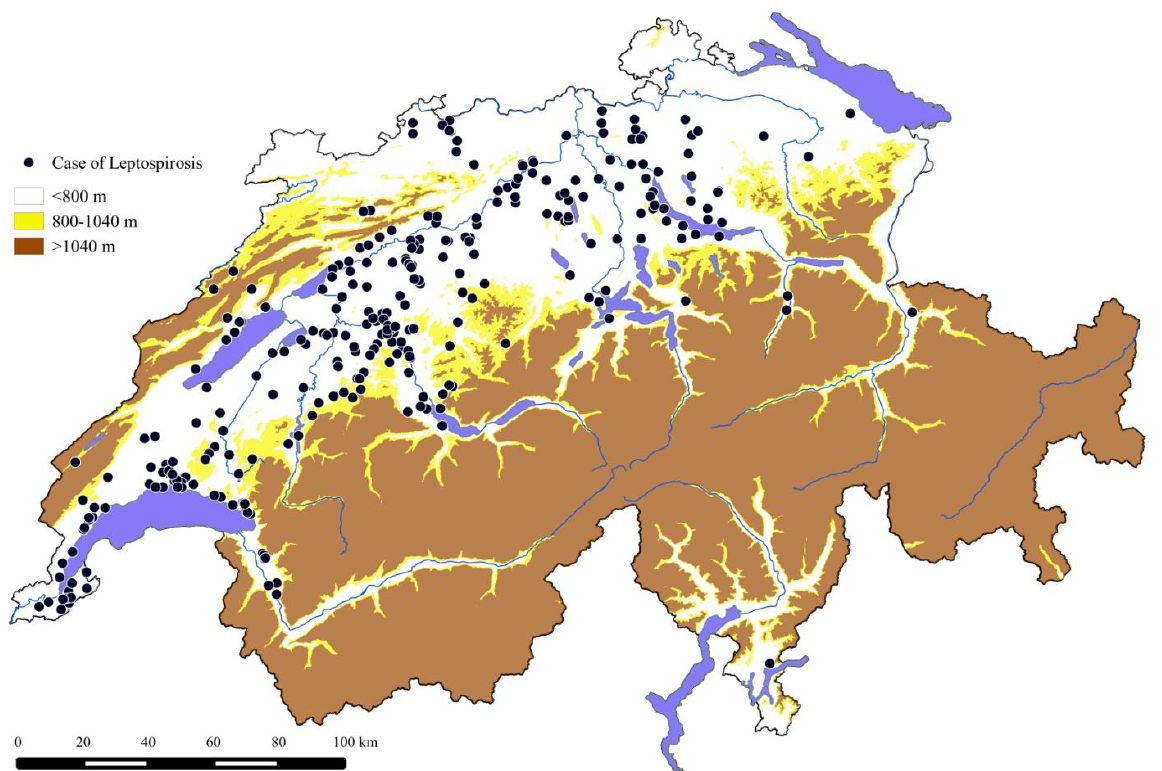
Figure 4. Geographic representation of the origin of 298 dogs diagnosed with leptospirosis (2003–2012) and their relationship to the